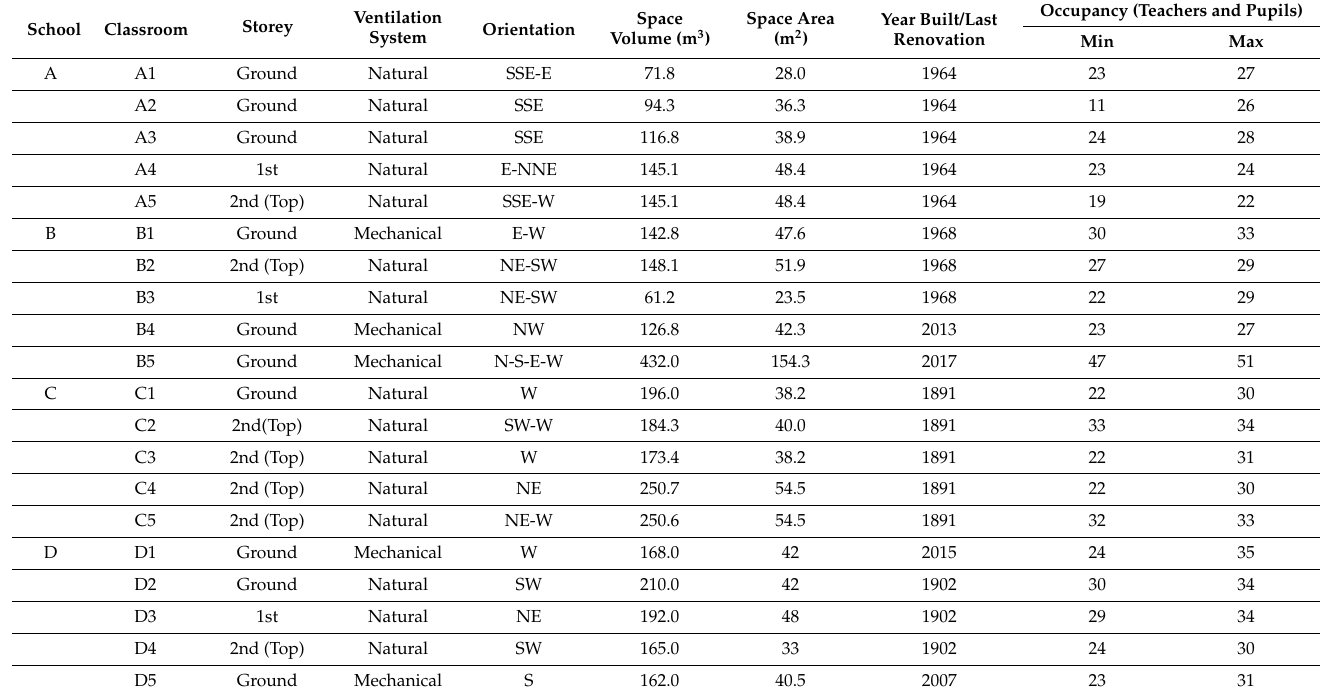
Table 1. Classroom’s typology where the measurements were